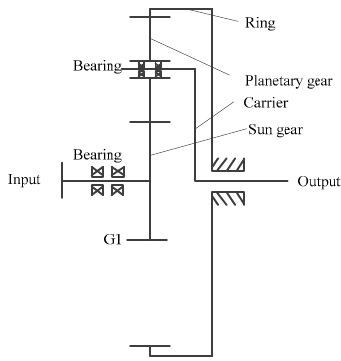
Figure 9. Structural diagram of 2K-H planetary gear set.